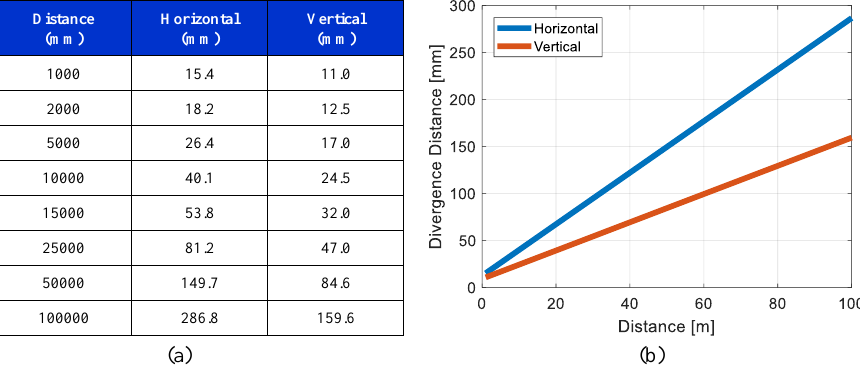
Figure 10. LiDAR beam divergence model: ( a ) divergence characteristics from VLP-16 specification and ( b ) divergence length over detection distance.